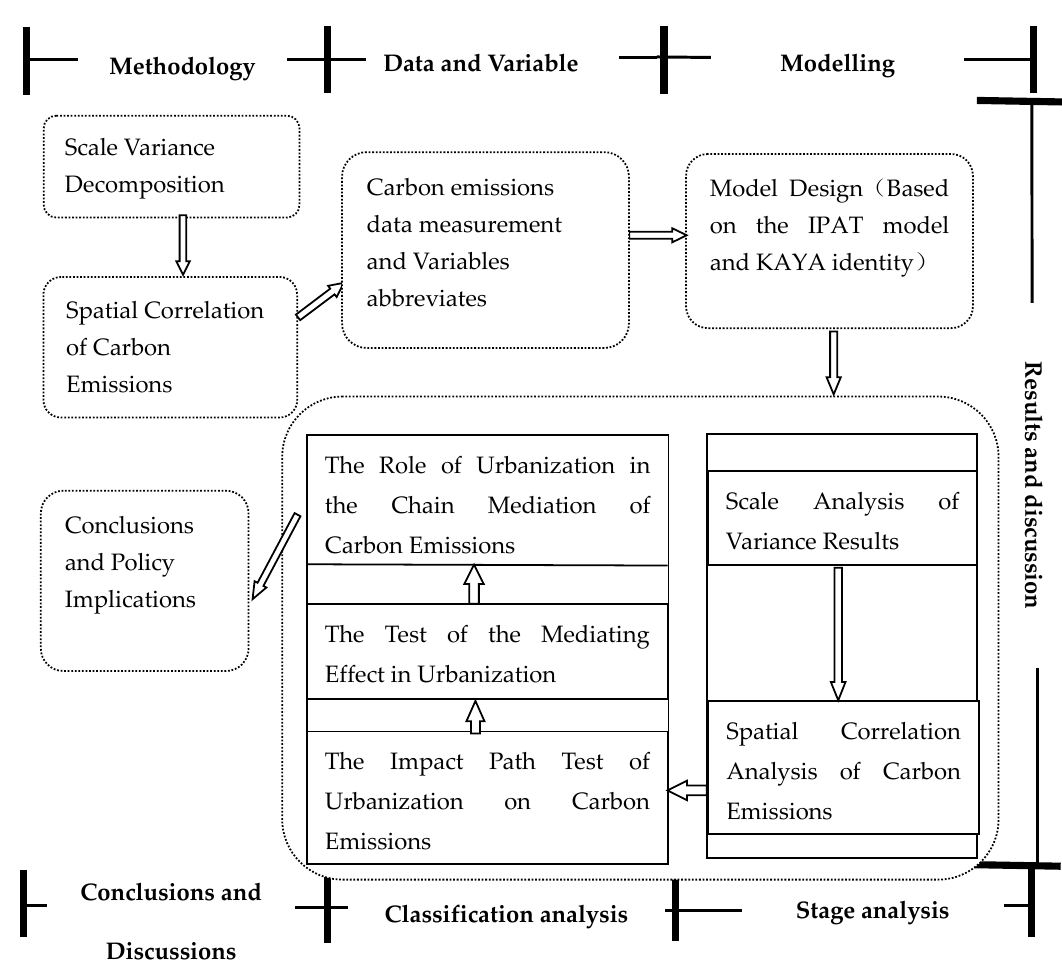
Figure 2. A flow chart of methodology.